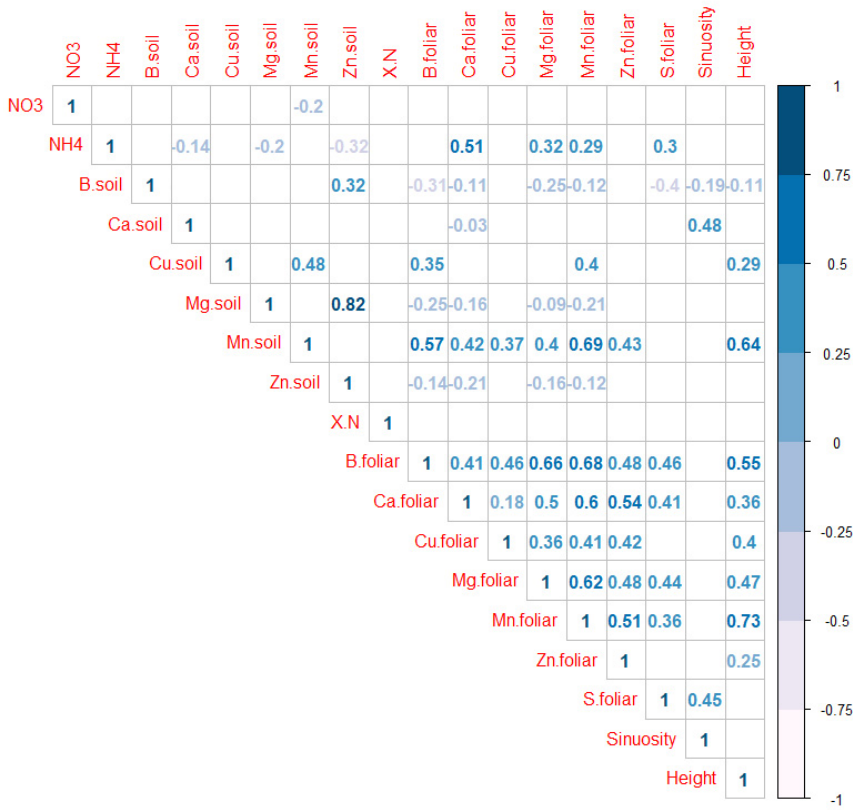
Figure 5. Correlation matrix of all nutrients and moisture content. All reported correlation coefficients are significant at p = 0.05. X.N refers to % nitrogen in the foliar samples.